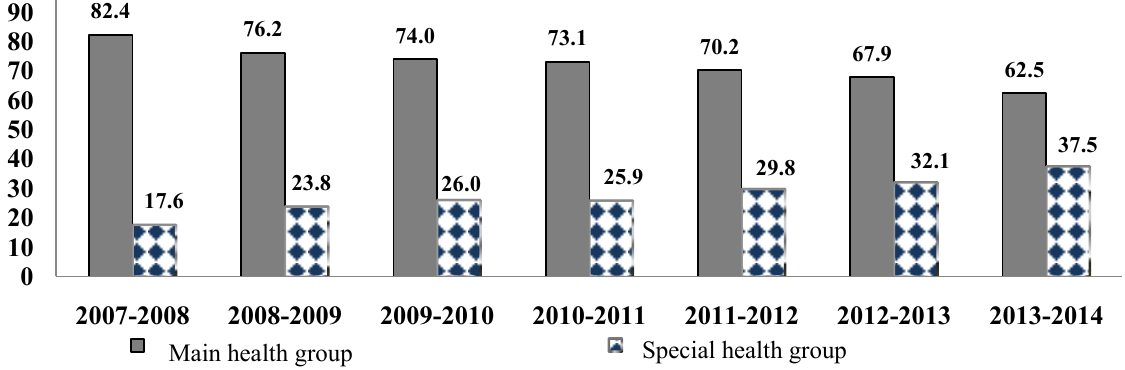
Fig.1. Correlation of students of main (MHG) special (SHG) groups in SRU “Bel SU” and